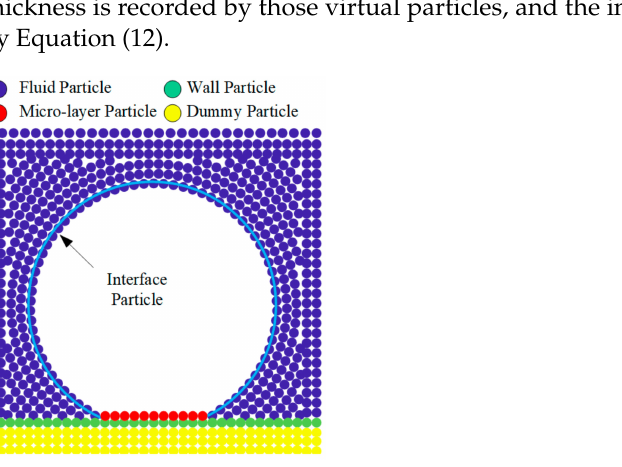
Figure 2. Arrangement of the initial bubble in current MPS-MAFL